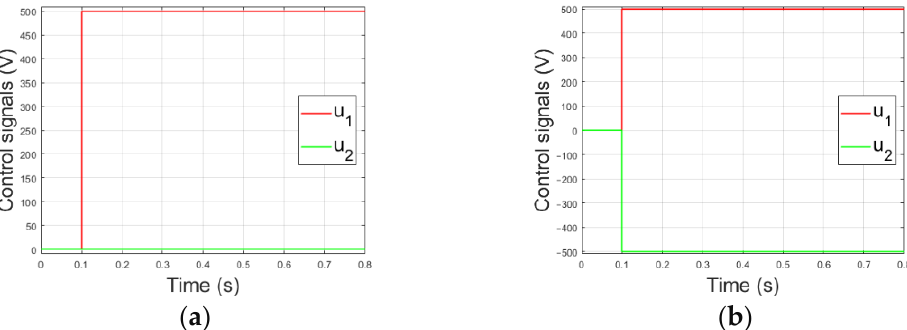
Figure 6. Courses of control signals in preliminary research: ( a ) one control sign for u 1 = +500 V and u 2 = 0 V, ( b ) for u 1 = +500 V and u 2 = − 500 V.